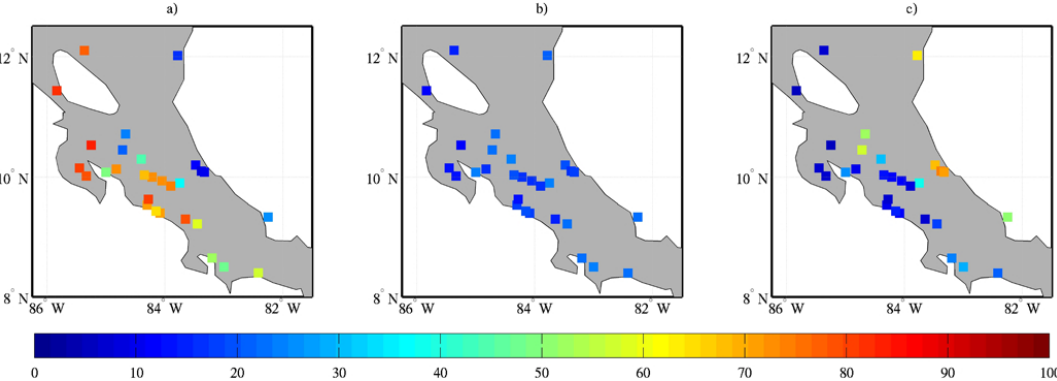
Fig. 11. CCA precipitation forecasts for ASO 2010 percentage of values exceeding the 80th percentile (p80) using July SST as predictor. Forecast probability maps are for categories (a) Above, (b) Normal, (c)